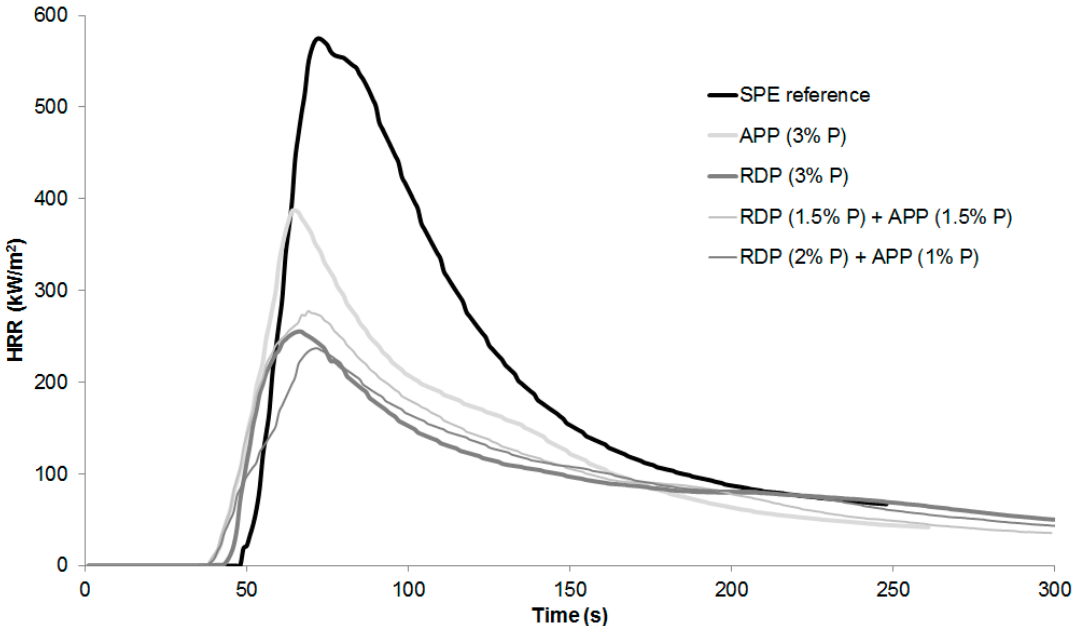
Figure 2. Heat release rate of reference and flame-retarded SPE samples.